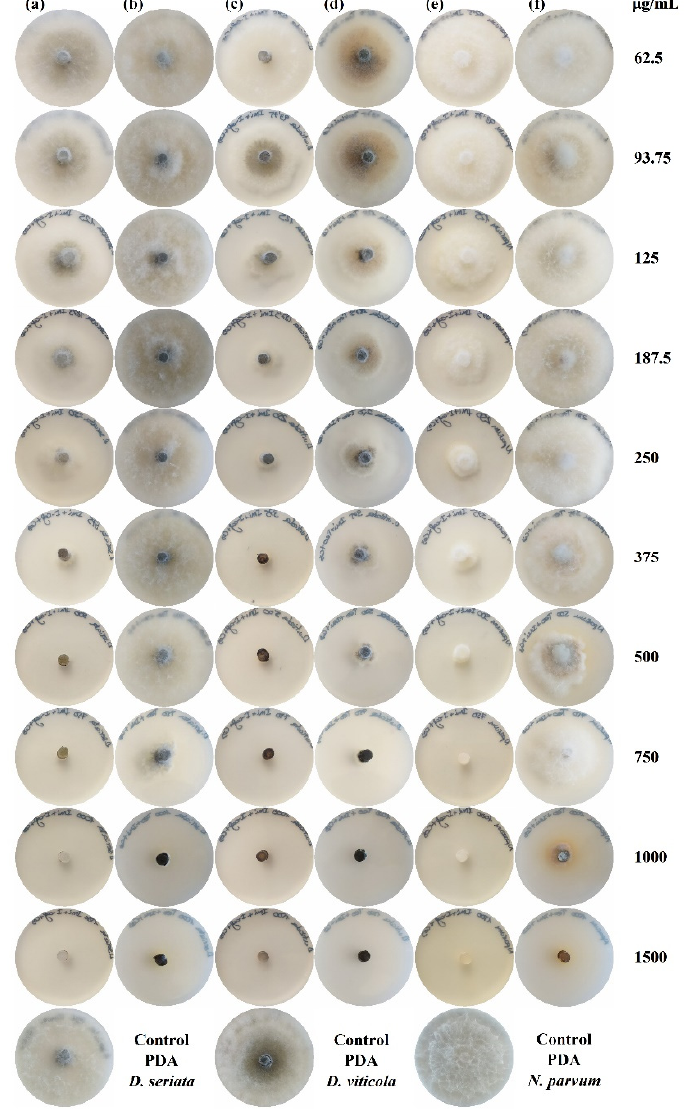
Figure 7. Mycelial growth inhibition for the three Botryosphaeriaceae fungi ( a , b ) D. seriata , ( c , d ) D. viticola , and ( e , f ) N. parvum upon treatment with COS–I-caffeine-imidazole ( a , c , e ) and COS–theophylline-imidazole ( b , d , f ) ternary conjugate complexes. Only one replicate per treatment and concentration is shown. The control plates (PDA with no treatment) are shown in the bottom row. Table 8. Treatment–lowest concentration combinations that achieve full inhibition of the Botryosphaeri- From the statistical comparison of all assayed treatments, if only the most effective aceae treatment–concentration combinations (i.e., those in the ‘a’ group according to Tukey’s HSD test) are selected (Table 8), it may be inferred that COS–I-caffeine-imidazole will be the most effective treatment. However, if imidazolic compounds are to be avoided due to legal restrictions (it is worth noting that, apart from sodium arsenite and methyl bromide, benzimidazole fungicides have also been phased out in some countries due to environ- mental and public health concerns [19]), then COS–I-caffeine would be the preferred choice.